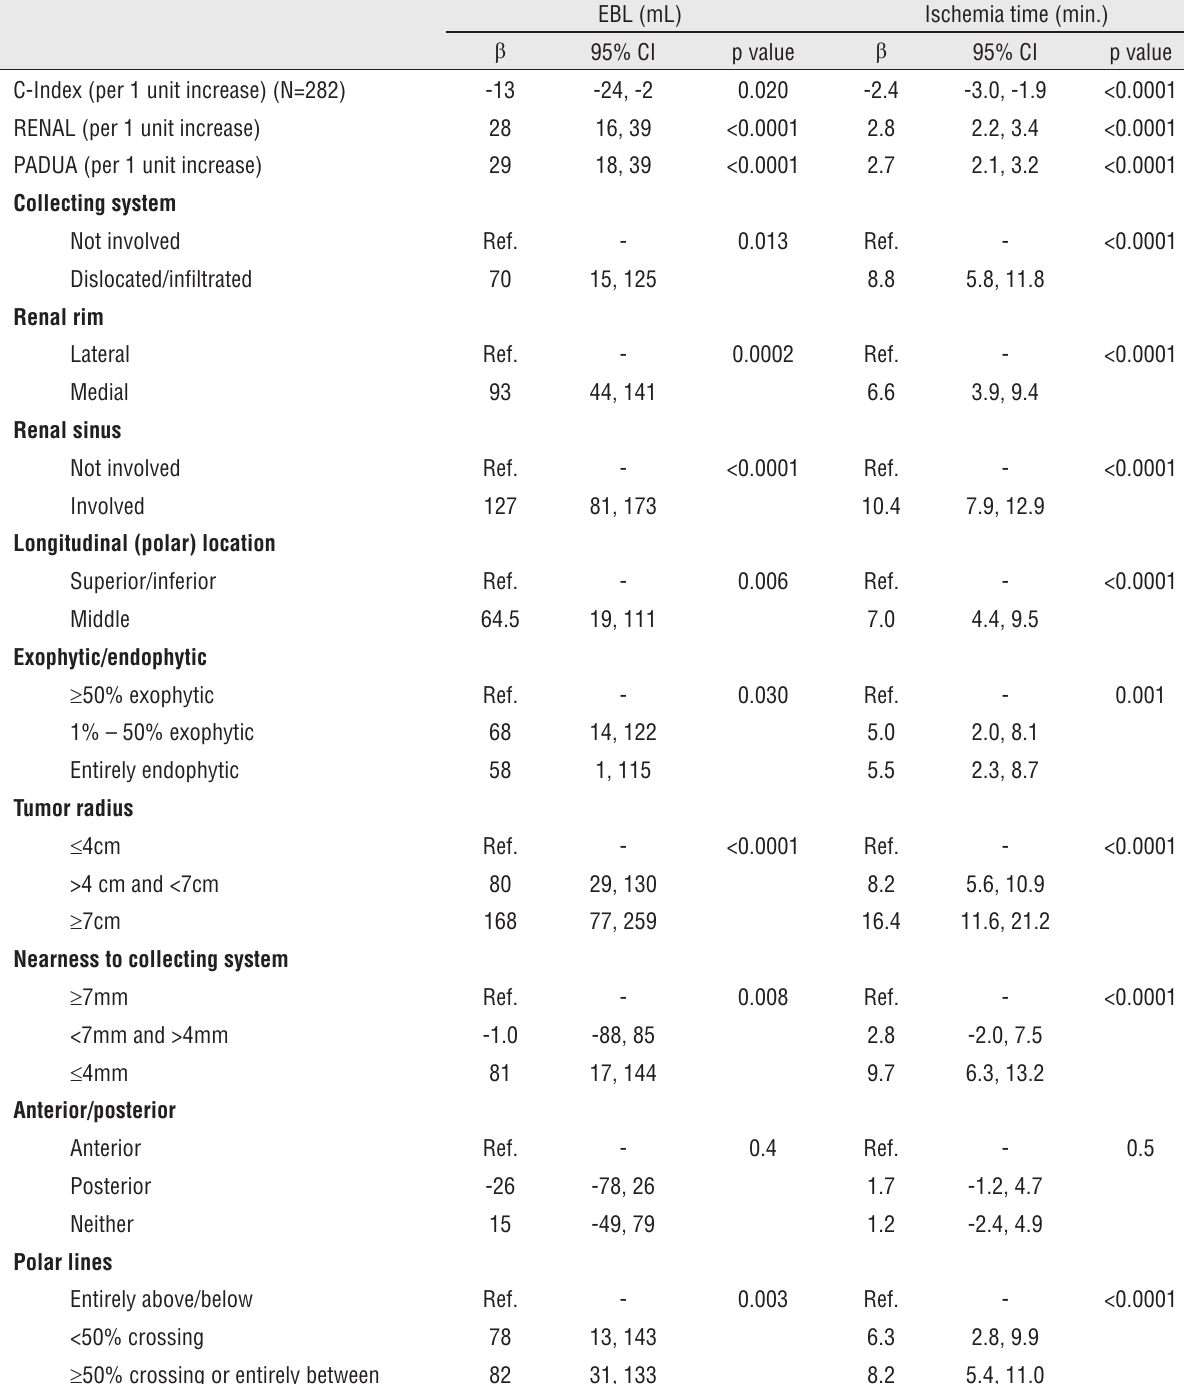
Table 3 - univariate linear regression models for the association between c-index, REnAL and pADuA total scores and subscales and peri-operative outcomes: estimated blood loss (EBL) in mL (n = 283) and ischemia time (IT) in minutes,